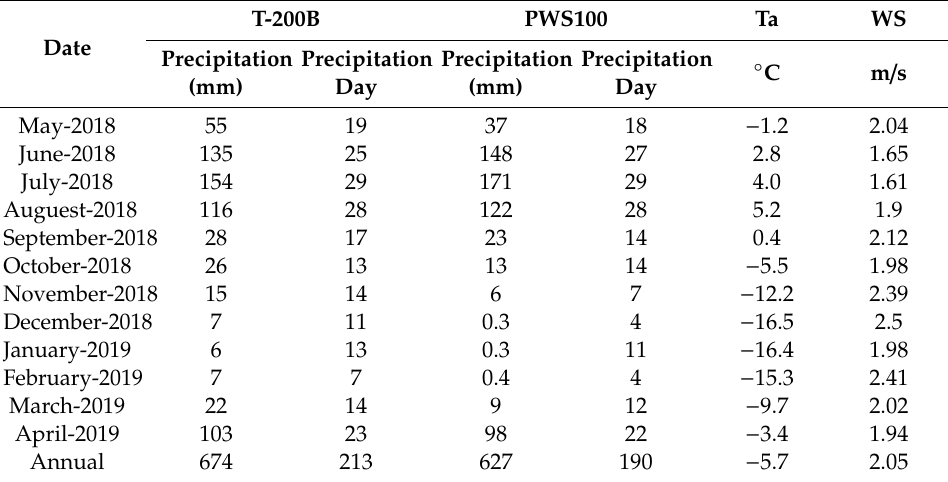
Table 1. Comparing the monthly precipitation amount and days measured on the observation